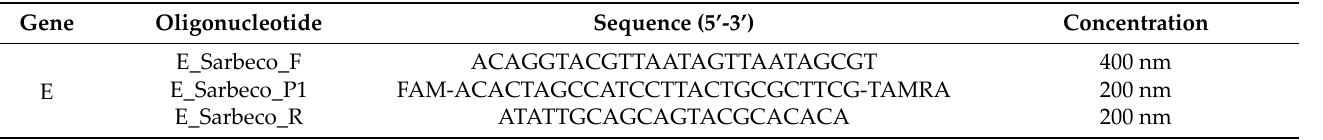
Table 1. Primers and Probes for the SARS‑CoV‑2 E gene. Gene Oligonucleotide